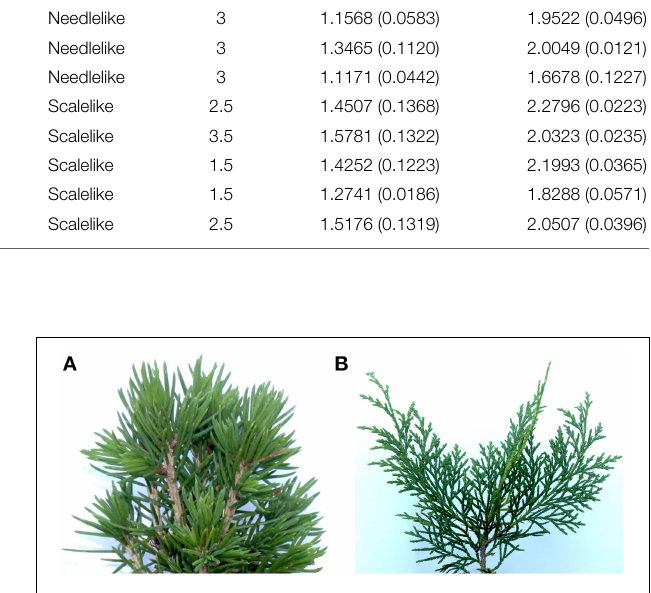
voltage, 120 kV. The X-ray beam width (i.e., a parameter to be distinguished from the thickness of CT images) was the same (1 mm) for all but one (the widest tree, for which 2 mm was used). Depending on the width of the crown, a different field of view was used: SS, very small (18 cm in diameter); S, small (24); or M, medium (32). A zoom factor was used to improve spatial resolu- tion horizontally; for example, for the crown of Chamaecyparis pisifera Golden Pin Cushion (Sawara Falsecypress), which had a width of 10.3 cm, a zoom factor of 1.5 was used with the SS field of view. Among the 11 miniature conifers that were CT scanned with the SS field of view, a zoom factor (ZF) was used for six (two times with ZF = 1 . 5 and four times with ZF = 1 . 2). Vertically, the thickness of CT images was 0.2, 0.3, or 0.4 mm, depending on the height of the tree; its width was also taken into account in order to have the same resolution as much as possible in all three dimensions (e.g., 0.23 × 0.23 × 0.20 mm 3 for Sawara Falsecypress). Between 400 and 600 CT images, each made of 512 × 512 CT numbers, were produced. Of all the CT images produced, a